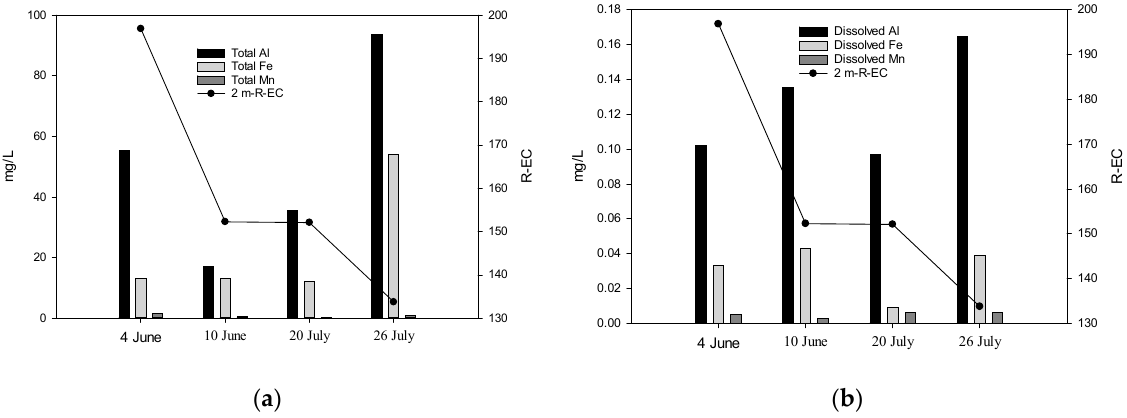
Figure 6. Changes in water quality at 2.0 m. ( a ) Changes in total heavy metal concentrations and ( b ) changes in dissolved heavy metal concentrations.